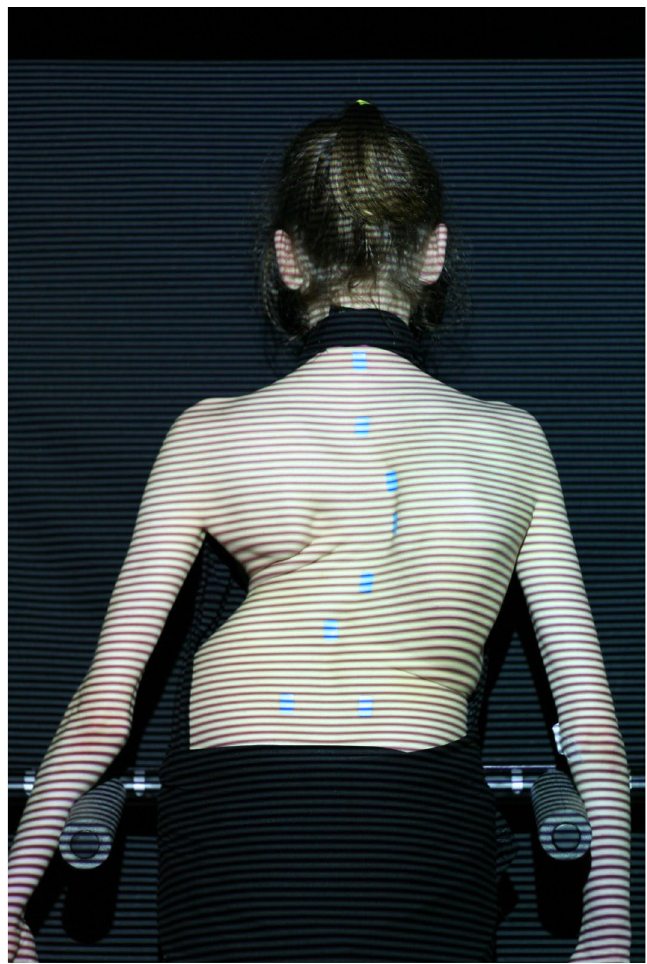
Figure 1. The ISIS2 clinical image with stickers placed over the spine, with the most superior sticker over the VP and the most inferior stickers over the